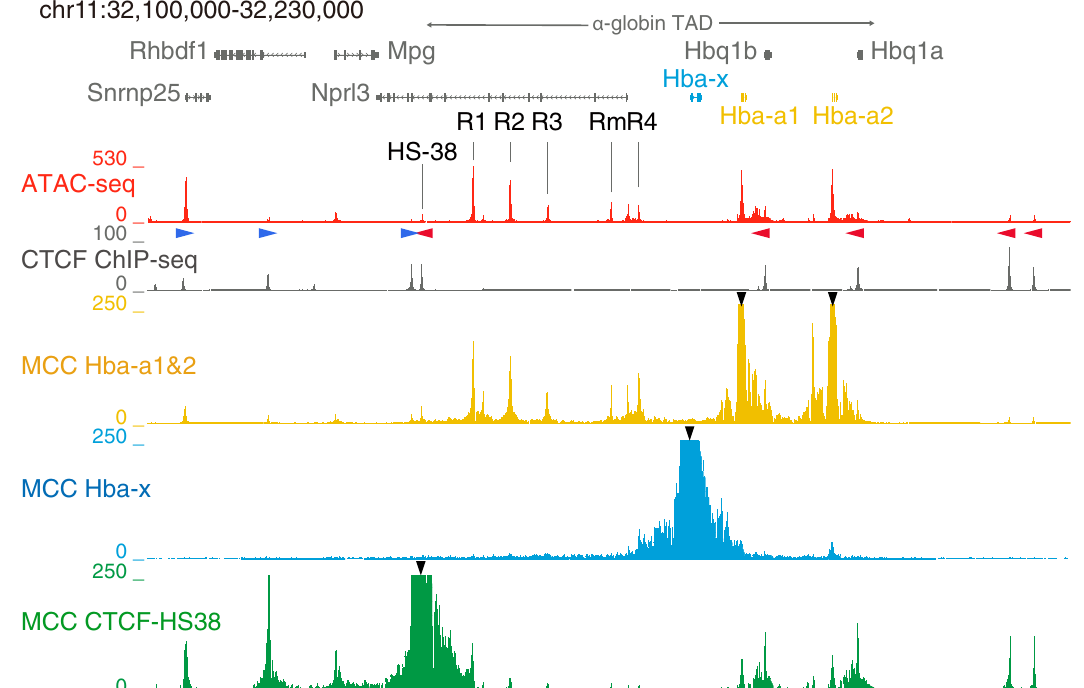
Fig. 5 Micro Capture-C (MCC) shows that the ζ -globin gene does not contact the α -globin enhancers in de fi nitive eryrthroblasts. MCC from the α - globin promoters (black arrowheads) shows speci fi c contact of these genes with the enhancers, interactions are represented by peaks at the enhancer elements in this track. Conversely, MCC from the viewpoint of the Hba-x promoter (black arrowhead) shows Hba-x does not contact the α -globin enhancers, or indeed any other sites within the α -globin TAD, suggesting it is isolated. MCC from the CTCF-binding site at HS-38 (black arrowhead) con fi rms this as it shows interaction with the α -globin genes but no contact with Hba-x . ATAC and CTCF binding pro fi les are shown for orientation. The orientation of CTCF-binding sites is shown by red and blue arrows and the extent of the α -globin TAD is indicated by a double-headed arrow.